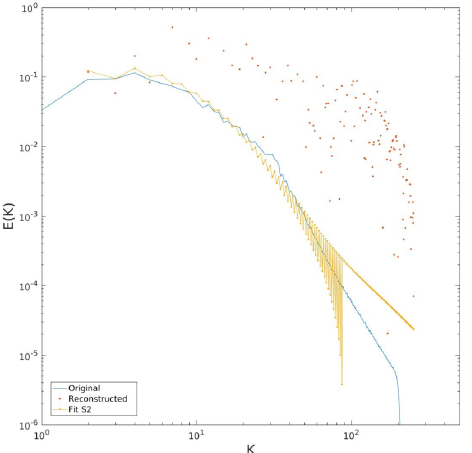
Figure 9. Kinetic energy spectra using the reconstruction based on (4), for the particle-derived second-order structure function ( red dots). Also shown is the reconstruction based on a sixth-order polynomial fit of the structure function ( yellow dotted